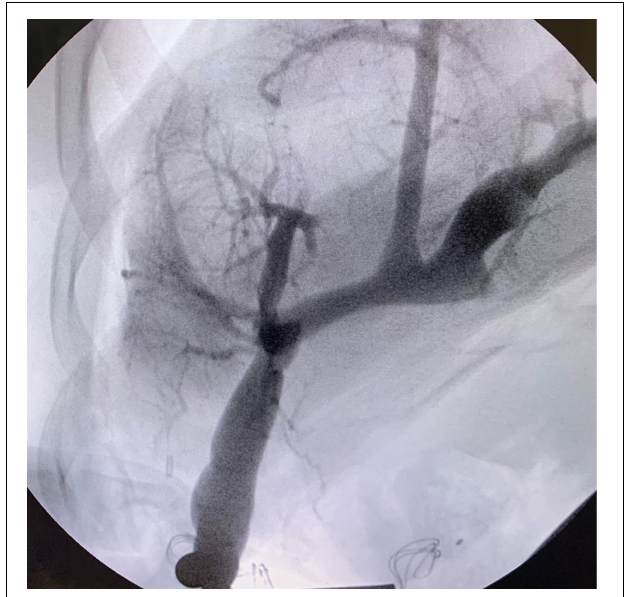
FIGURE 3 | Portal venography via the anastomosed graft with evidence of good flow into the liver.